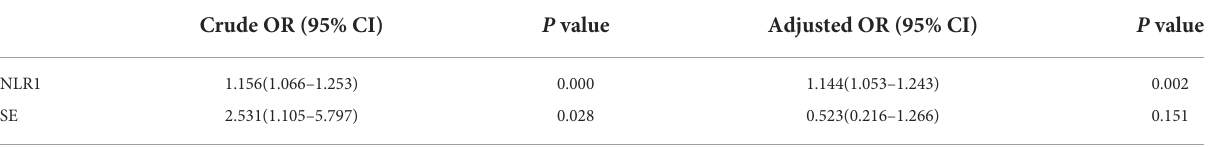
TABLE 6 Univariate and multivariate logistic analyses of possible predictors for the following recurrent seizure attacks after